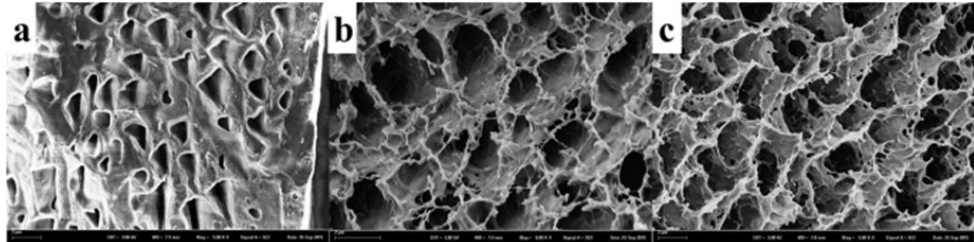
Figure 1. FESEM images of P407/CMCs hydrogel across the skin ( a ) blank hydrogel (PC200), ( b ) 2% P407/CMC loaded hydrogel, ( c ) 4% P407/CMC loaded hydrogel (PC204) (Reprinted from [107] Wang, W. Wat, E. Hui, P.C.L. Chan, B. Ng, F.S.F. Kan, C.W. Wang, X. Hu, H. Wong, E.C.W. Lau, C.B.S. Leung, P.C. Dual-functional transdermal drug delivery system with controllable drug loading based on thermosensitive poloxamer hydrogel for atopic dermatitis treatment. Images reproduced with permission from Scientific Report (2016), https://creativecommons.org/licenses/by/4.0/ (Accessed on 16 February 2023)).